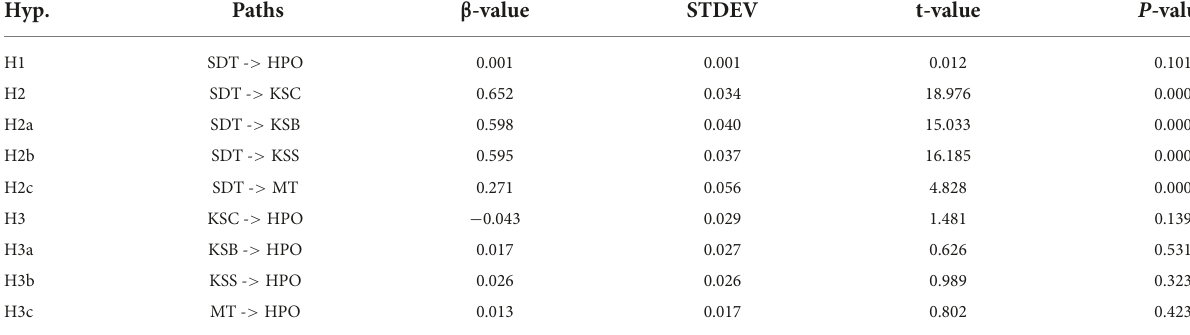
TABLE 5 Direct hypothesis